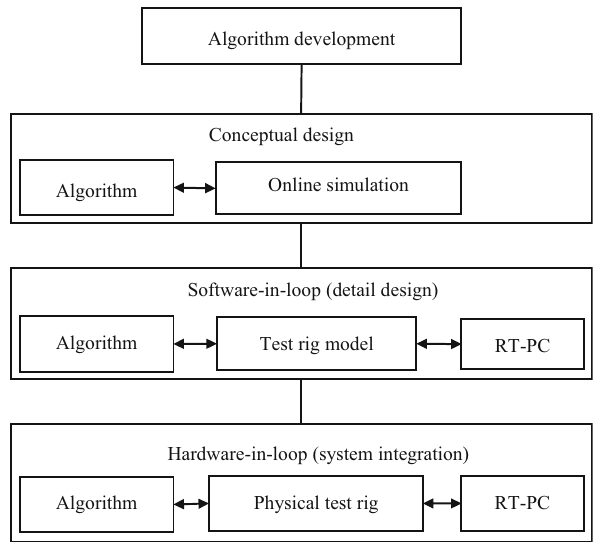
Fig. 1 Development stages of the scaled bogie test algorithm development phase and conceptual design phase